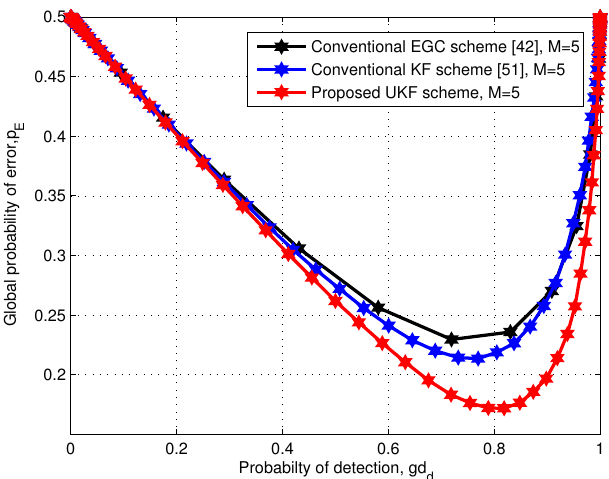
Figure 8. Probability of error comparison between an equal gain combining (EGC), Kalman filter (KL) and unscented Kalman filter (UKF) with different numbers of CUs, i.e., M = 5 and signal to noise ratio (SNR) = [ − 8, − 11, − 14, − 17, −